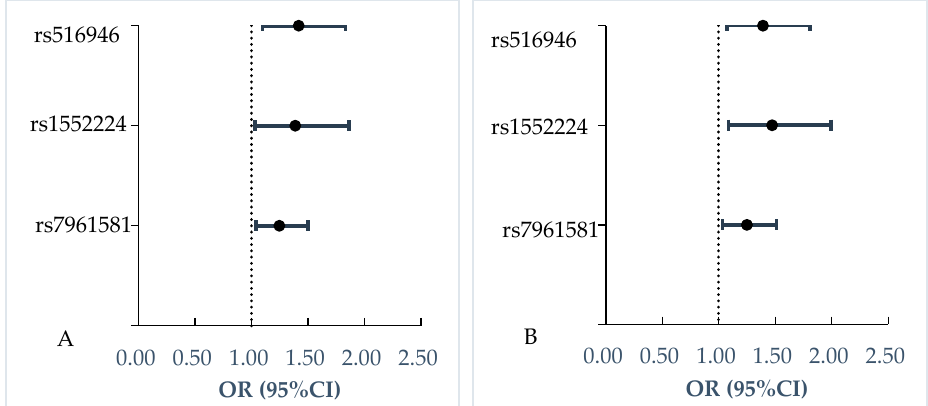
Figure 2. Association of three SNPs with impaired insulin release. ( A ) Model 1 was logistic regression model to analyze the association of individual SNP with quantitative traits without adjusting for any covariates. ( B ) Model 2 was logistic regression model to analyze the association of individual SNP with quantitative traits adjusting for gender, economical status, education levels, BMI, waist circumference, sedentary time, exercise, whole cereal and beans intake levels, livestock and poultry intake levels, drinking, and smoking.